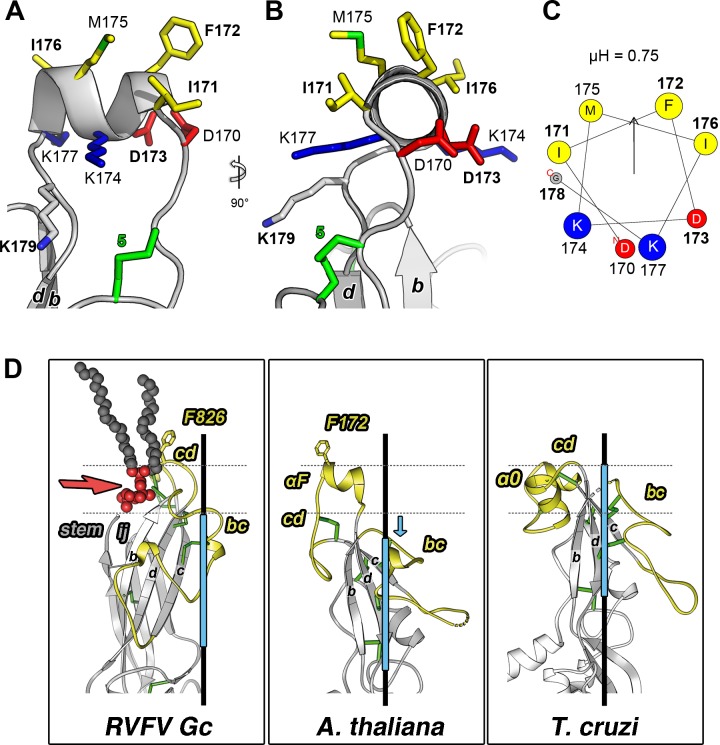
The AtHAP2 fusion helix.(A-B) Gray ribbon representation of AtHAP2 αF at the tip of domain II. Side chains of apolar (yellow), negatively charged (red), and positively charged (blue) residues are represented as sticks and labeled, with disulfides in green and numbered as in Fig 1; residues interrogated in subsequent experiments are in bold. (A) and (B) show two orthogonal views. (C) Helical wheel projection of αF; circle size is proportional to side chain size (amino acids colored as in A and B). The hydrophobic moment of the amphipathic α helix (μH) predicted by Heliquest [22] is displayed as a vertical arrow and its value indicated above the diagram. (D) The tip region of AtHAP2 is displayed in the central panel, with TcHAP2 on the right and the fusion protein Gc of the RVFV (PDB 6EGU; [13]) on the left, with a phosphatidyl-choline lipid bound in a glycerophospolipid-specific pocket in between the cd connection and the top end of the bdc β-sheet (the lipid is shown as connected spheres with the head group red and the aliphatic tails dark gray). The horizontal dotted lines mark roughly the borders of the polar lipid head group region of the membrane, based on this structure. In the central and right panel, the dotted lines show the predicted span of the polar head group region based on the aromatic residues that project into the aliphatic portion of the membrane. This location is clearer in the case of AtHAP2, in which F172 is placed at the same level as F826 in the viral protein. In the case of TcHAP2, the conformation of this region may have changed, as the nonpolar residues do not project out. The dotted lines are therefore only tentative. The trimer axis is shown in black, and the light blue bar indicates the region superposed in Fig 2B, which is shifted down in the case of AtHAP2, as indicated by the blue arrow, such that the end of the bdc β-sheet is predicted to be away from the membrane. In all three panels, the bc and cd connections are in yellow, the conserved scaffold in gray, and disulfides as green sticks. AtHAP2, A. thaliana HAP2; PDB, Protein Data Bank; RVFV, Rift Valley fever virus; TcHAP2, T. cruzi HAP2